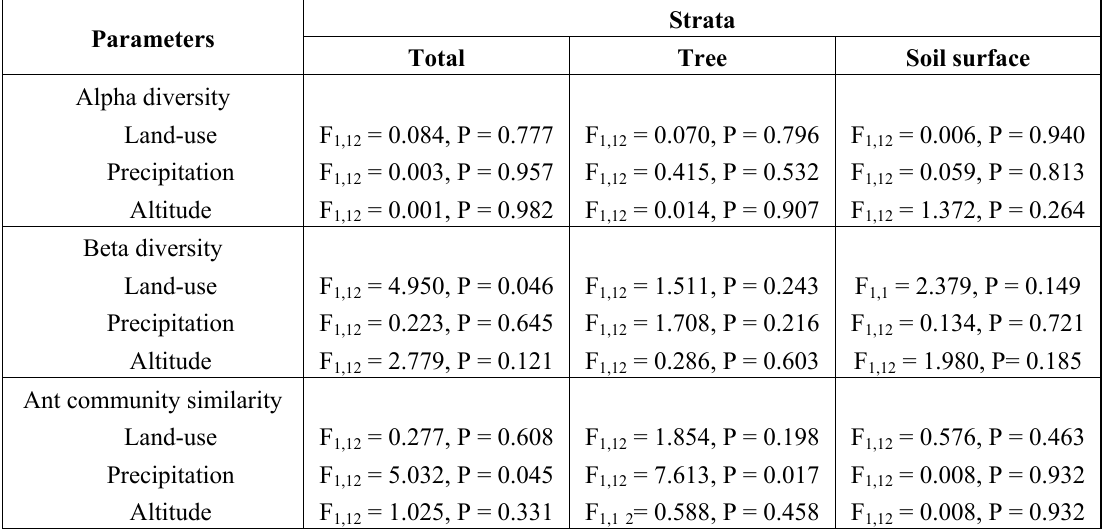
Table 2. Effects of shade-tree removal, precipitation and altitude on species richness per tree (alpha diversity), beta diversity and community similarity of ant communities in each stratum, based on 16 cacao agroforestry plots.